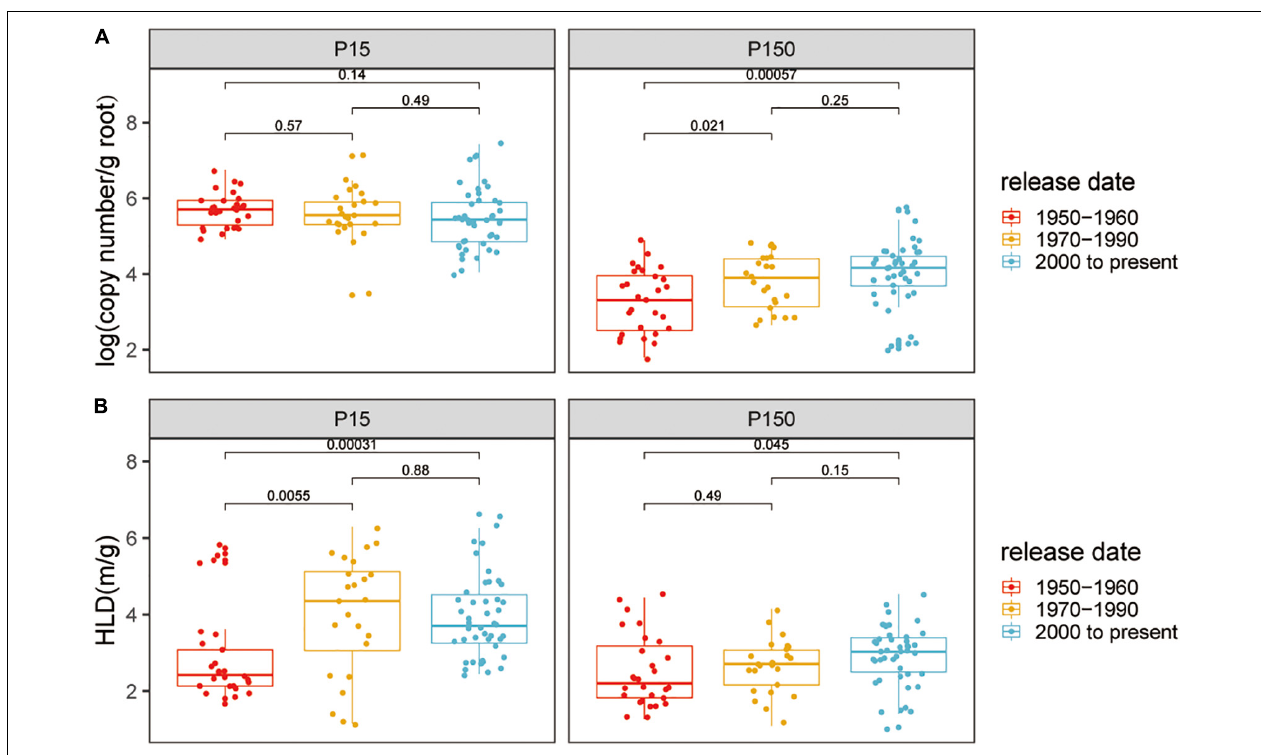
FIGURE 1 | (A) Arbuscular mycorrhizal (AM) fungal gene copy number and (B) the hyphal length density (HLD) of cotton varieties inoculated with indigenous AM fungi under low or high phosphorus (P) supply. The groups (and bar patterns) are as follows: 1950–1960 (red), 1970–1990 (yellow), and 2000 to present (blue). We define those from “1950–1960” and “2000 to present” as the old and modern varieties, respectively. Boxes show first quartile, median, and third quartile. Whiskers extend to the most extreme points within 1.5 × box lengths and the points are values that fall outside the whiskers. The Wilcoxon signed-rank test was carried out among different groups and the p -value is